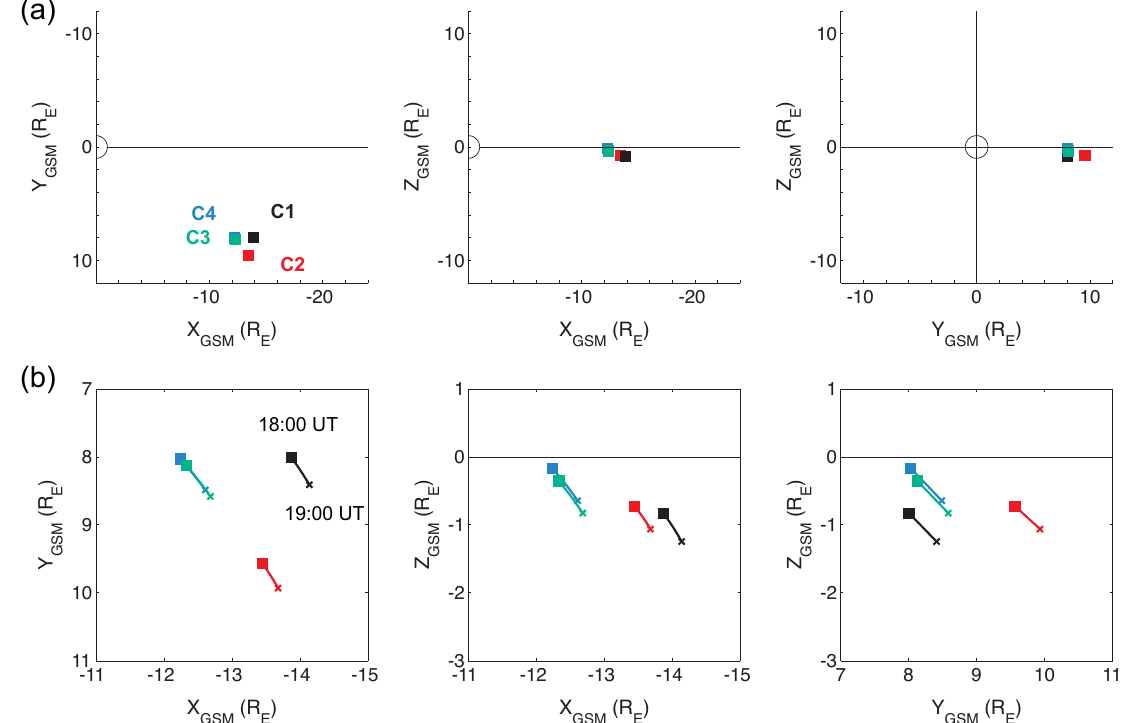
Fig. 2. (a) Cluster spacecraft positions in GSM coordinates on 17 October 2005 at 18:00UT. (b) Zoomed view showing Cluster trajectories from 18:00 (square) to 19:00UT